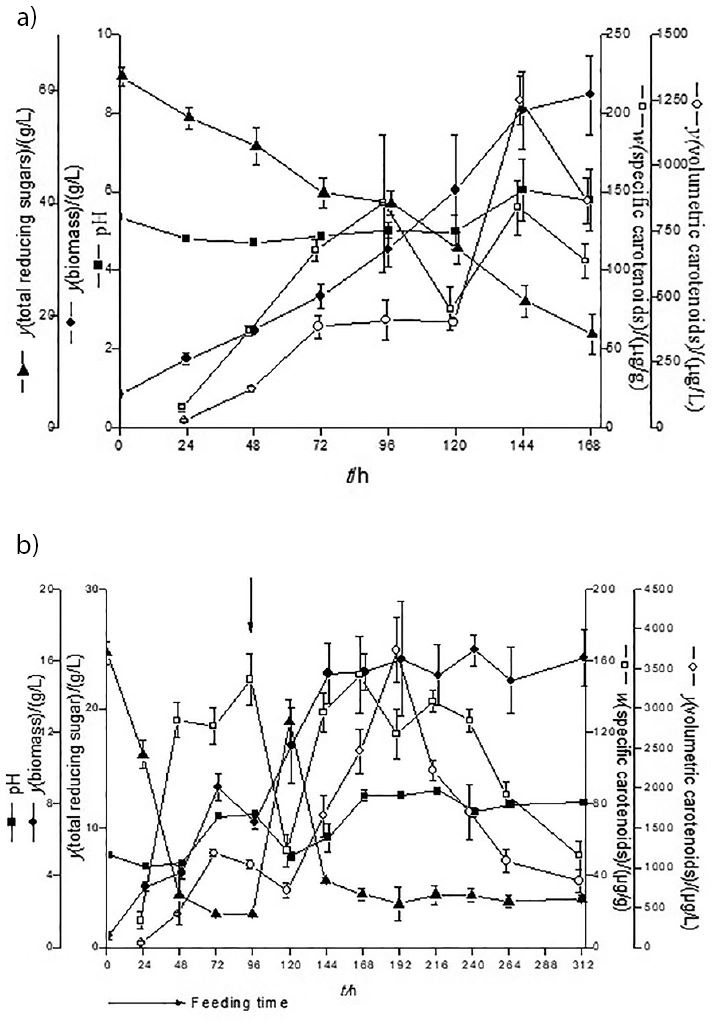
Kinetics of the carotenoid production by Rhodotorula mucilaginosa at 25 °C, 180 rpm and an initial pH=6.0: a) γ(sugar cane molasses)=70 g/L and γ(corn steep liquor)=3.4 g/L used to validate the empirical models (N=3), b) γ(sugar cane molasses)=30 g/L and γ(corn steep liquor)=6.5 g/L in a fed-batch fermentation at feeding time t=96 h